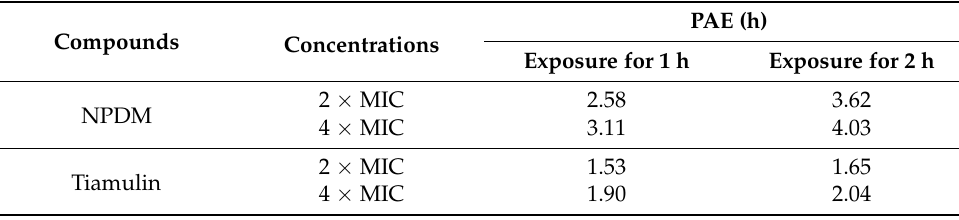
Figure 3. The bacterial growth kinetic curves for MRSA ATCC 43300 exposed to NPDM for 1 h ( A ) or 2 h ( B ) and tiamulin for 1 h ( C ) or 2 h ( D ). Table 2. The PAE values of NPDM and tiamulin against MRSA ATCC 43300. Table 2. The PAE values of NPDM and tiamulin against MRSA ATCC 43300. Compounds Compounds